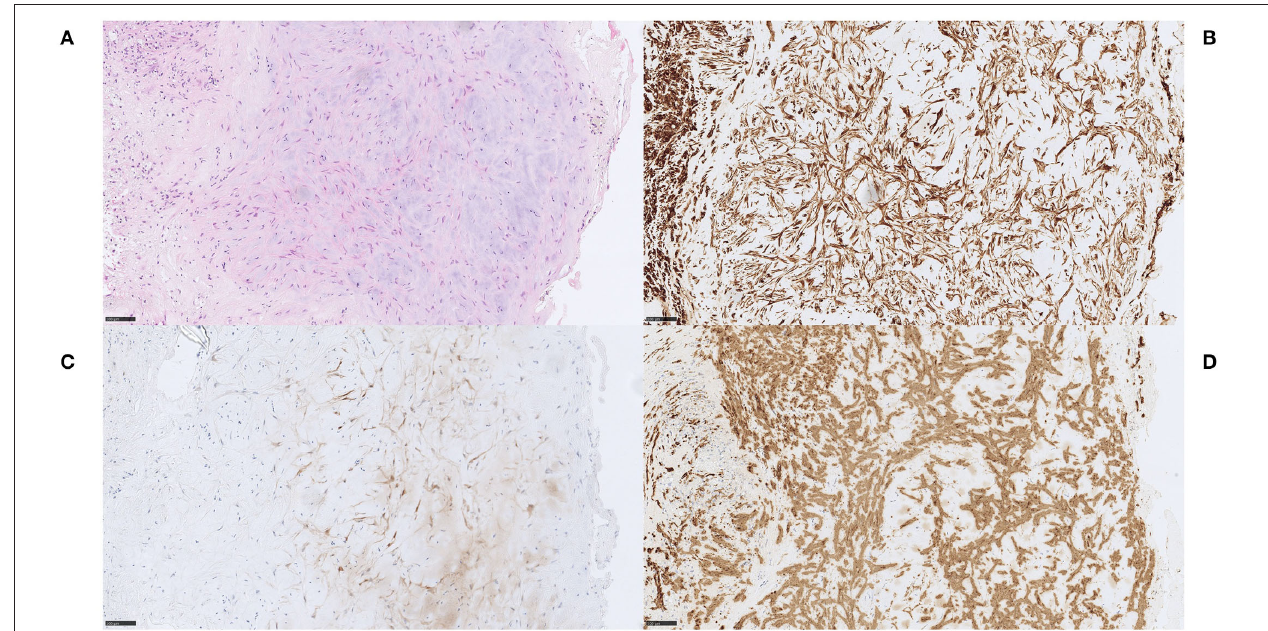
FIGURE 8 | Myxomatous material. Case 5 Stellate cells with eosinophilic cytoplasm, arranged in cords and networks within a myxoid stroma, surrounded by aggregates of macrophages (A) H&E, 200x. Capillaries and scattered inflammatory cells were found within the myxoid stroma and glandular structures without mucin formation were identified focally. No mitotic activity, necrosis or hemosiderin deposits were seen. Stellate cells were consistently immunoreactive for Vimentin (B) Vimentin, 200x, PGP9.5 (C) PGP9.5, 200x and α -SMA (D) α -SMA, 200x, while variable or focal immunoreactivity for CD31 and calretinin were seen (not shown). NSE and S100 were negative (not shown). Vessels and capillaries showed immunoreactivity for CD31 and CD34 (not shown). The diagnosis of embolism of a cardiac myxoma in this case is not firmly established (no clinical data on cardiac tumor). We favored a cardiac myxoma embolism even though we cannot completely rule out the possibility of embolism of myxomatous material from other locations, e.g., cardiac valves and a carotid web. In our opinion, a definitive diagnosis of cerebral embolism of a cardiac myxoma should be made only after histopathological comparison between MT specimen and a surgically resected cardiac mass, confirming the primary diagnosis. Scale bar = 100 µ